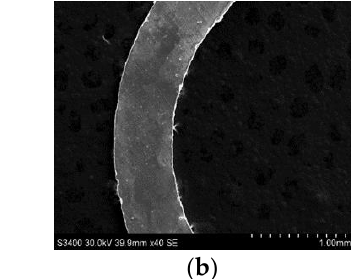
Figure 16. The scanning electron microscopy (SEM) photographs of the final aluminum ring: ( a ) integral photograph; ( b ) local photograph.